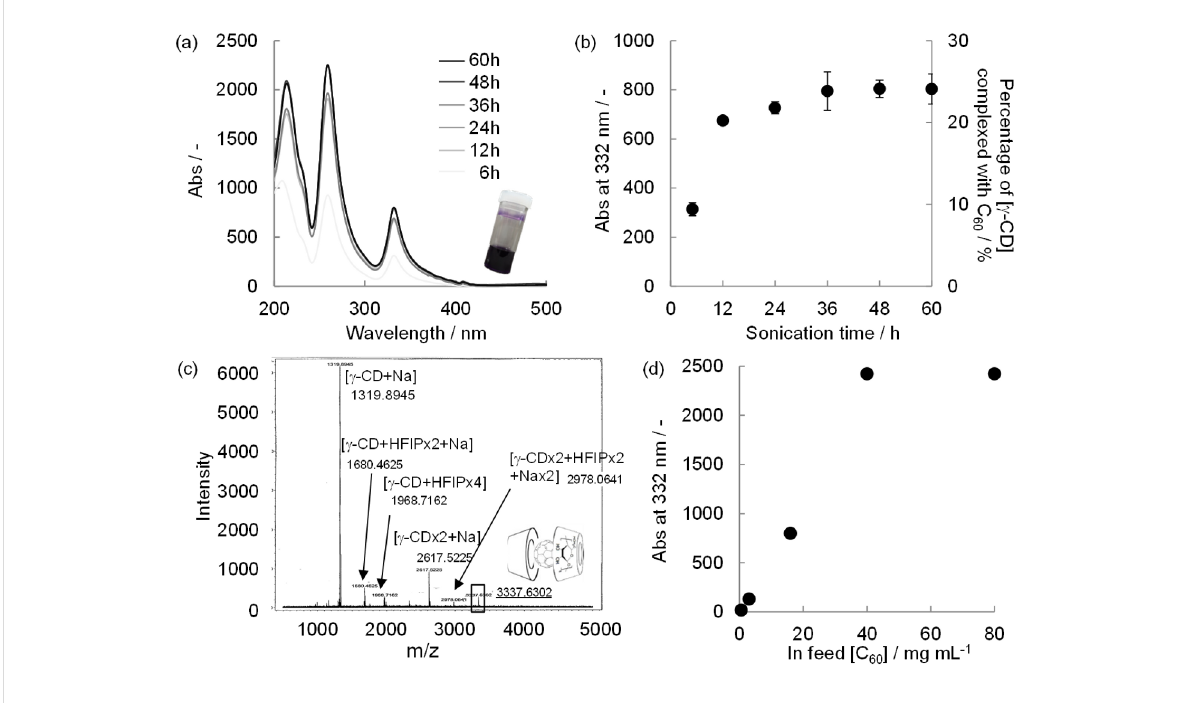
Figure 2: Formation of a γ -CD–C 60 inclusion complex in HFIP under sonication for 60 h. (a) UV–vis absorption spectra of the solutions. Inserted photograph shows a typical, purple-colored complex solution. (b) UV–vis absorbance at 332 nm (left y-axis) and the percentage of γ -CD complexed with C 60 (right y-axis) with sonication time ( n = 3). C 60 (16 mg mL − 1 ) was added to 15 w/v % of γ -CD/HFIP. (c) ESI-mass spectrum of a typical com- plex solution shows the formation of the 2:1 complex by the peak at 3337.6302. (d) UV–vis absorbance of the final solution vs feed C 60 amount (0.6, 3.2, 16, 40, 80 mg mL − 1 , n =